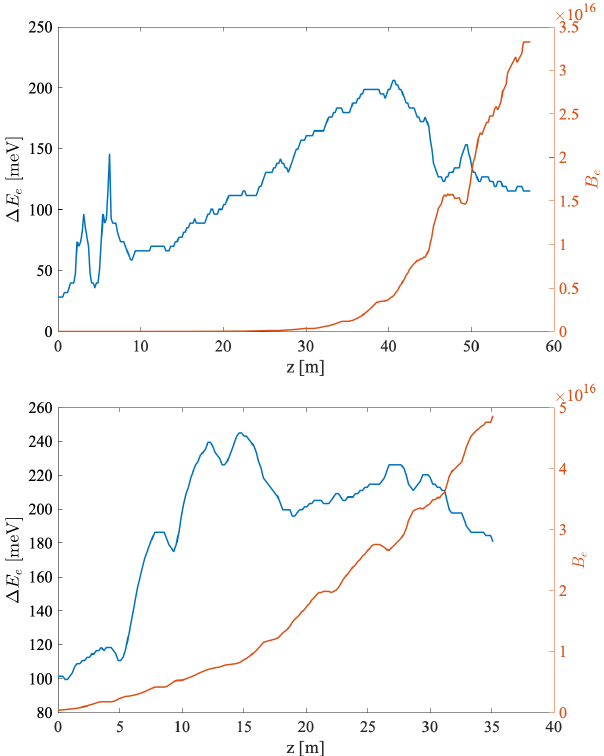
FIG. 7. SXRSS x-ray spectral bandwidth and brightness evo- lution with S2E e-beam at 1.2 keV (top) and 620 eV (bottom). The FWHM-equivalent bandwidth Δ E e first grows then is reduced somewhat near saturation as the taper